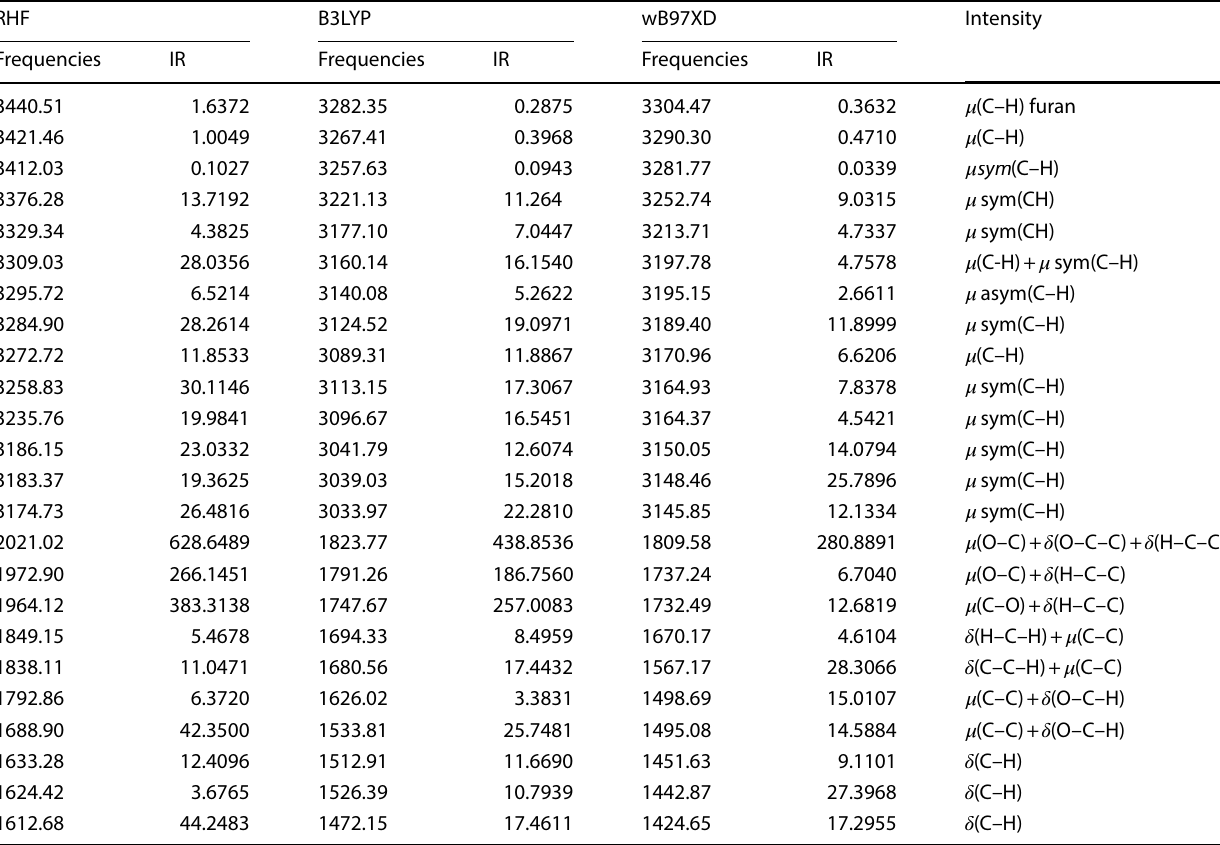
Table 2 Comparison between infrared and Raman frequencies calculated by the RHF, B3LYP and wB97XD methods for